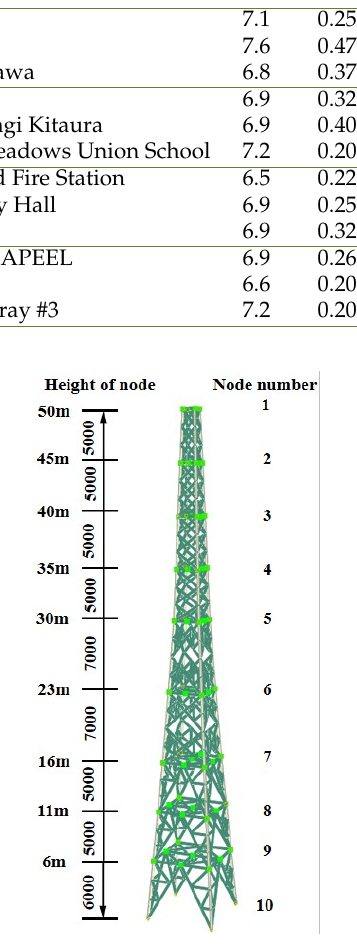
Fig. 9. Node distribution of the communication